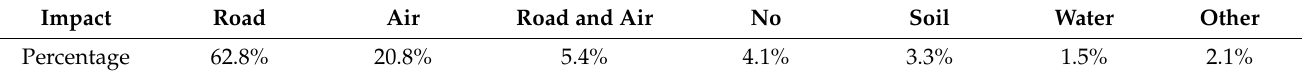
Table 5. The impact of hazmat accidents.